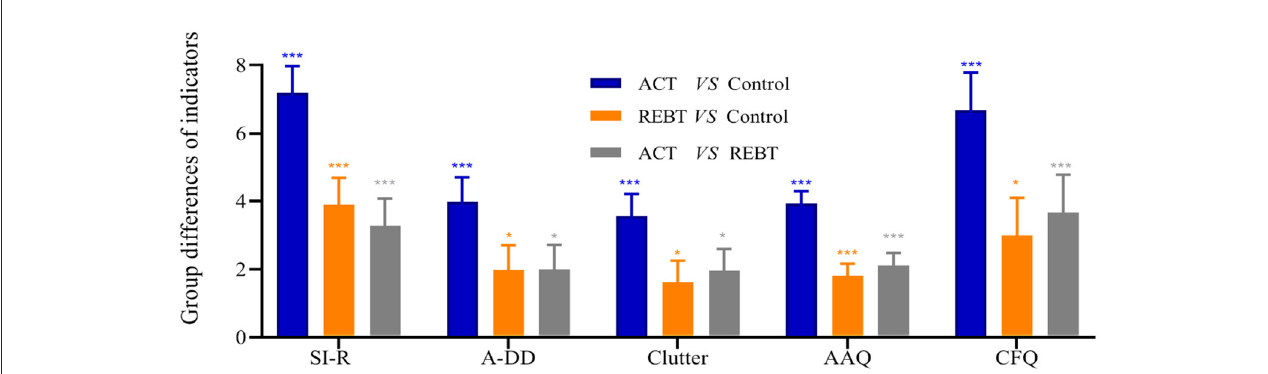
FIGURE2 The results of Bonferroni’s post hoc comparison (SI-R, A-DD, Clutter, AAQ, and CFQ). * p < 0.05; *** p < 0.001; Blue bar, Difference between ACT group and Control group; Orange bar, Difference between REBT group and Control group; Gray bar, Difference between ACT group and REBT group. SI-R, the scores of Saving Inventory-revised; A-DD, (Acquisition-Difficulty Discarding) the subscale scores of SI-R; Clutter, the subscale scores of SI-R; AAQ, the scores of Acceptance and Action Questionnaire–II; CFQ, the scores of Cognitive Fusion Questionnaire.